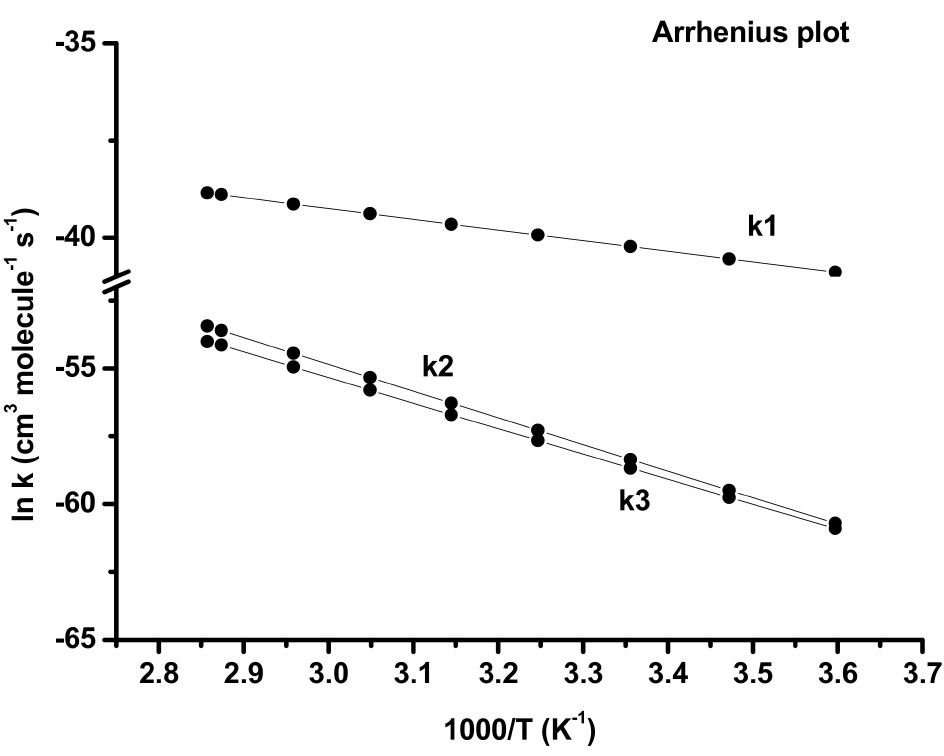
Figure 7. The Arrhenius plot of trans-2-pentenal reaction with O 3